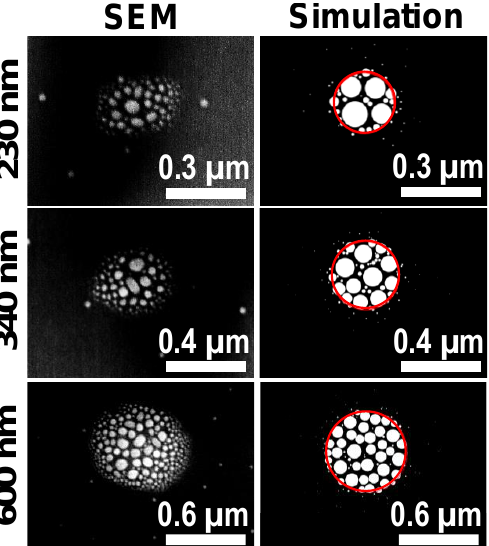
Figure 2. SEM images ( left ) of Ga droplets after area-selective deposition without annealing for varied diameters d of the mask aperture together with corresponding simulated surface morphologies ( right ). The red circles in the simulated surfaces indicate the size of the aperture. The experimental parameters are F = 0.35 ML/s, θ = 40 ML, and T = 100 °C. The simulations are performed using E S = 0.46 eV, E E = 1.24 eV, as well as an aperture size-dependent temperature of 50 °C at d = 230 nm, 65 °C at d = 340 nm, and 100 °C at d = 600 nm (see